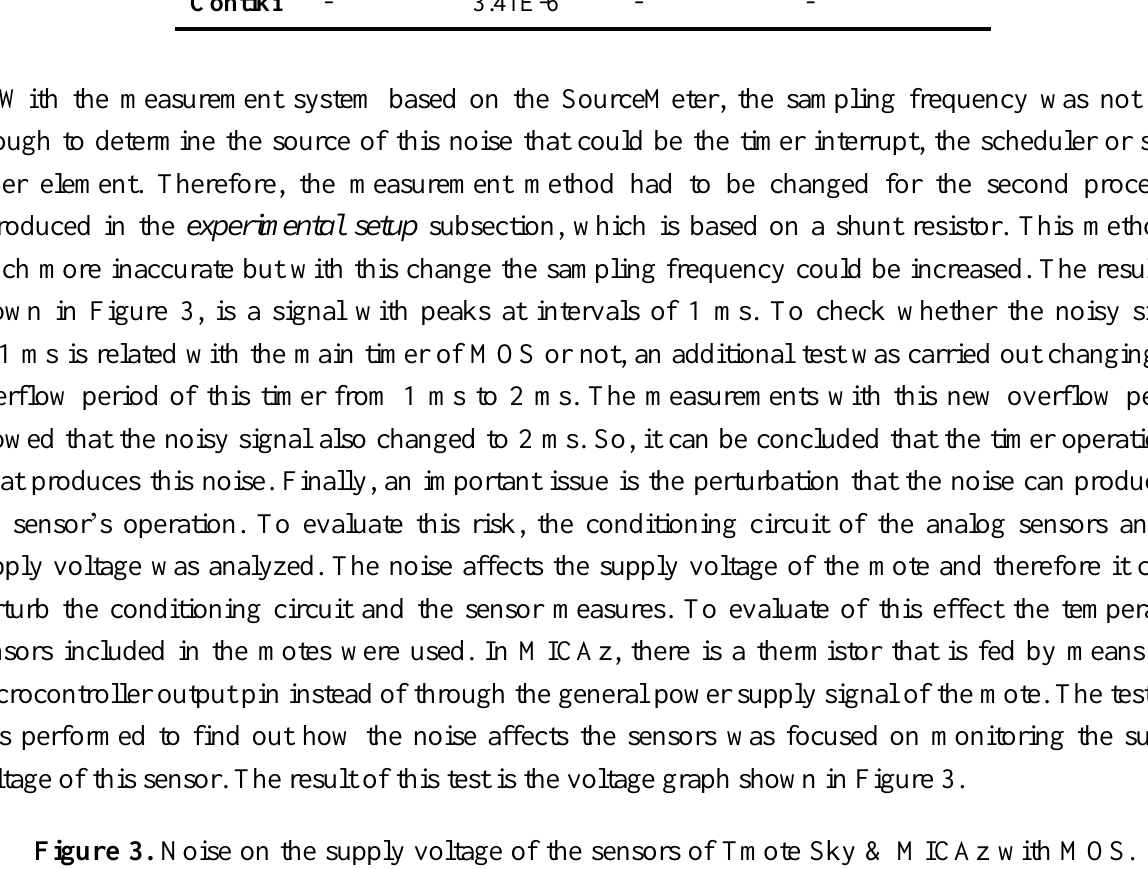
Figure 3. Noise on the supply voltage of the sensors of Tmote Sky & MICAz with